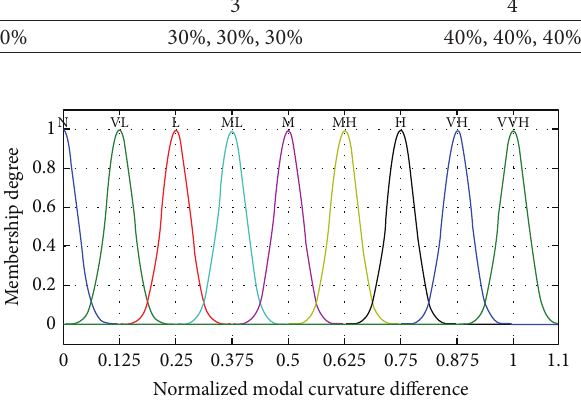
Figure 9: Membership function for input variables. Table 4: Fuzzy sets for output